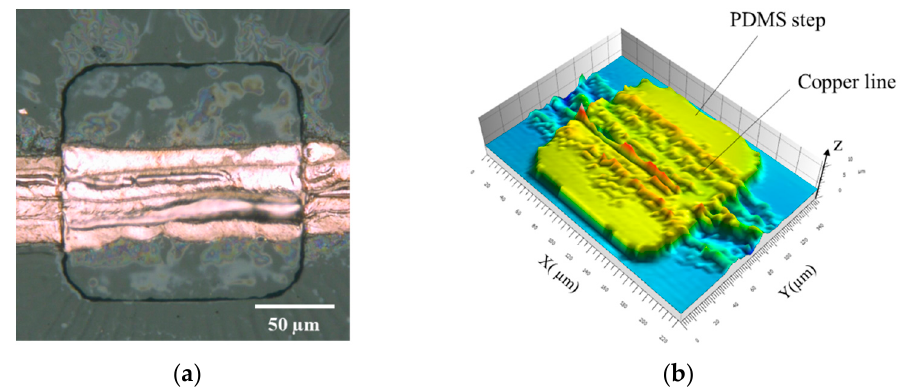
Figure 7. ( a ) Optical microscope image of the patterns on a PDMS step structure (top view). ( b ) 3D mapping of the fabricated Cu pattern. mapping of the fabricated Cu